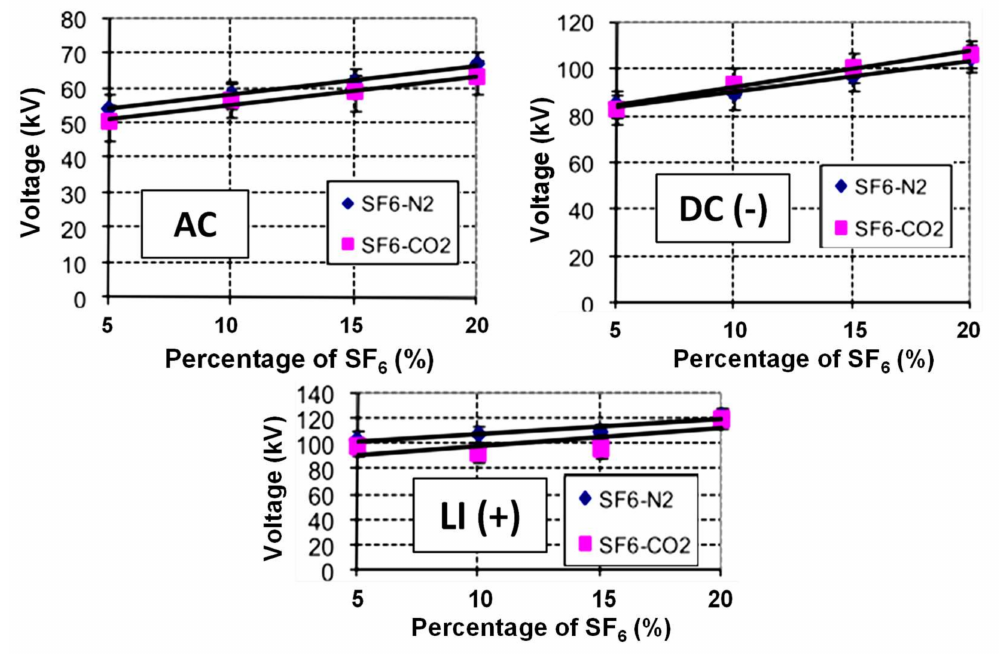
Figure 10. Comparison of the breakdown voltage of SF 6 –N 2 and SF 6 –CO 2 mixtures in sphere–sphere electrode arrangement under different types of voltage waveforms at p = 2